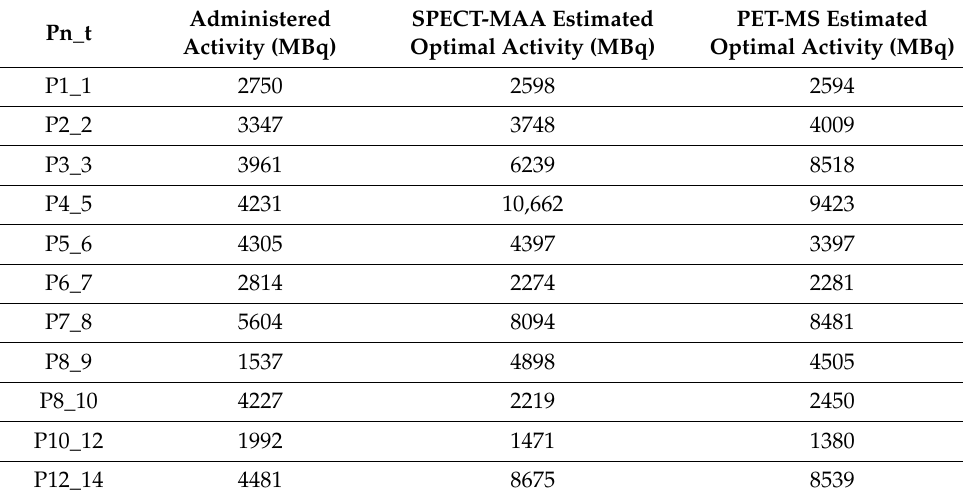
Table 4. Administered and estimated optimal activities based on SPECT-MAA and on PET-MS for each of the 11 treatments, with OF converging for a maximum between 0 and 12 GBq.